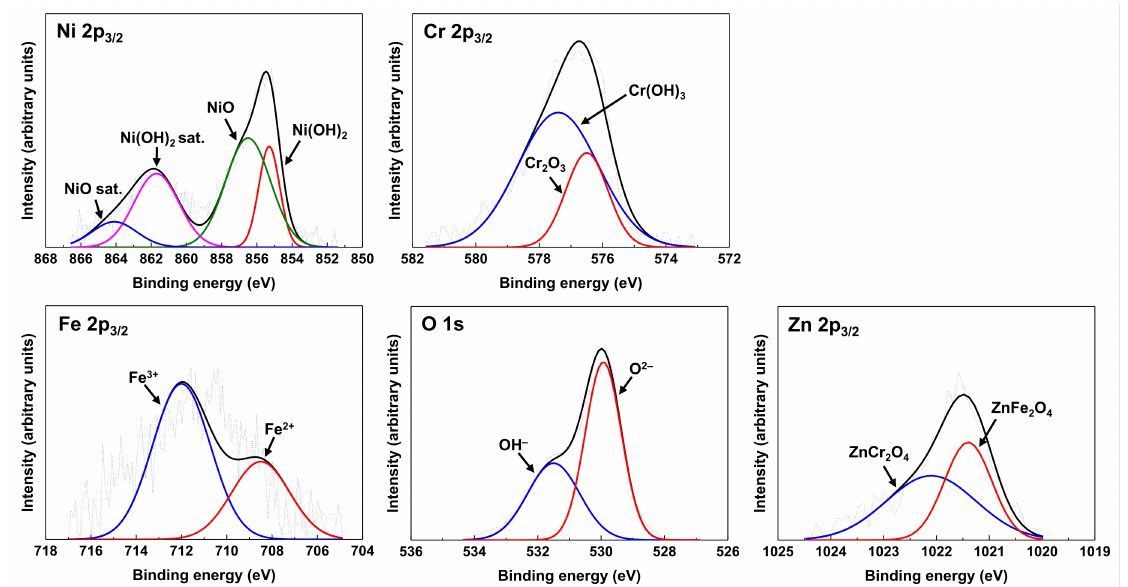
Figure 8. XPS spectra of Ni, Cr, Fe, O, and Zn from the oxide formed on Alloy 690 under the Case #2 condition.